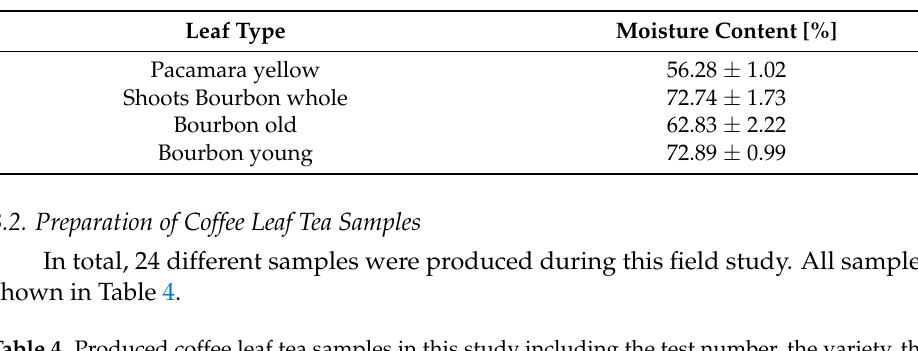
Table 4. Produced coffee leaf tea samples in this study including the test number, the variety, the leaf type, the processing, the drying and the fermentation